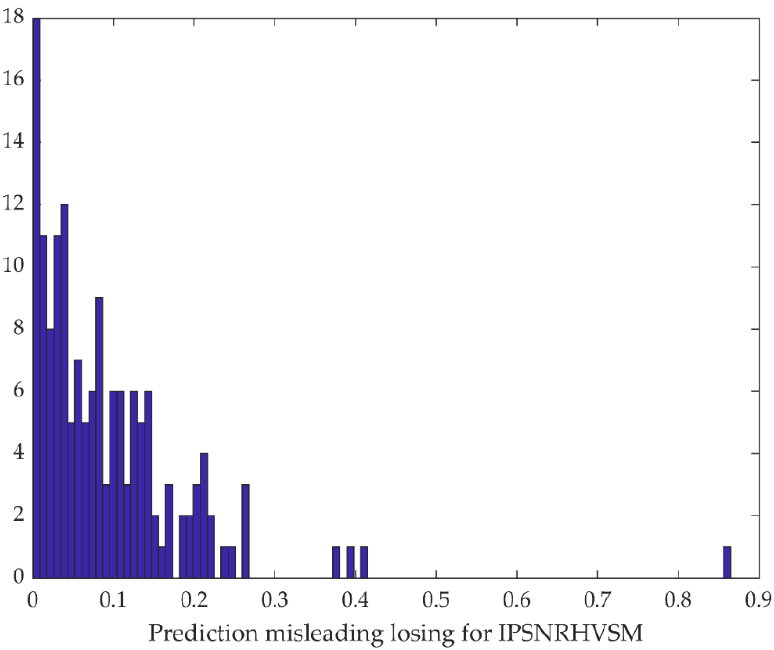
Figure 13. Histogram of differences between the optimal and produced IPHVM in cases of wrong decisions.